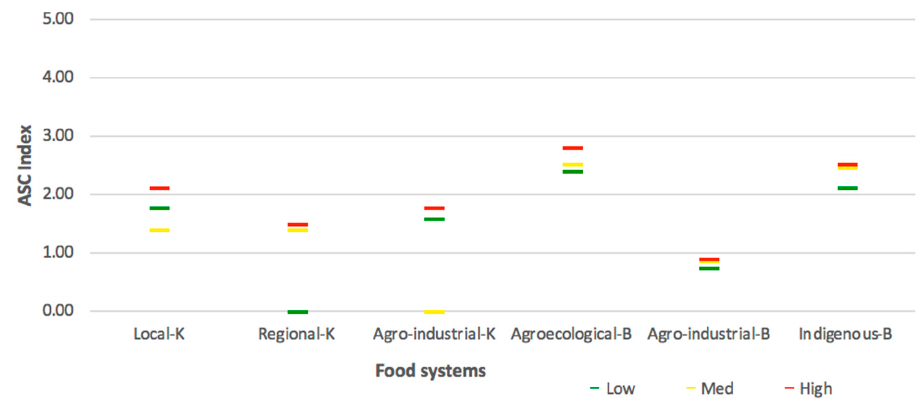
Figure 8. Agroecosystem capacity index of 18 farm-based agroecosystems.